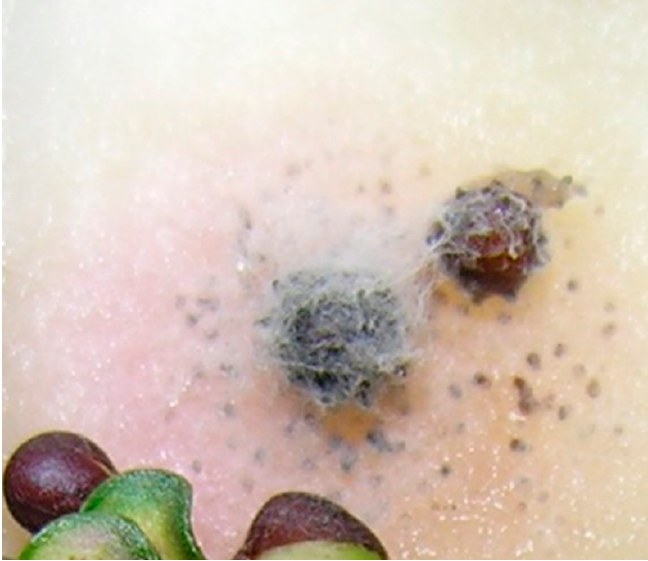
Figure 1. Canola seeds infected with Leptosphaeria species. Dark dots on and around seeds represents pycnidia.